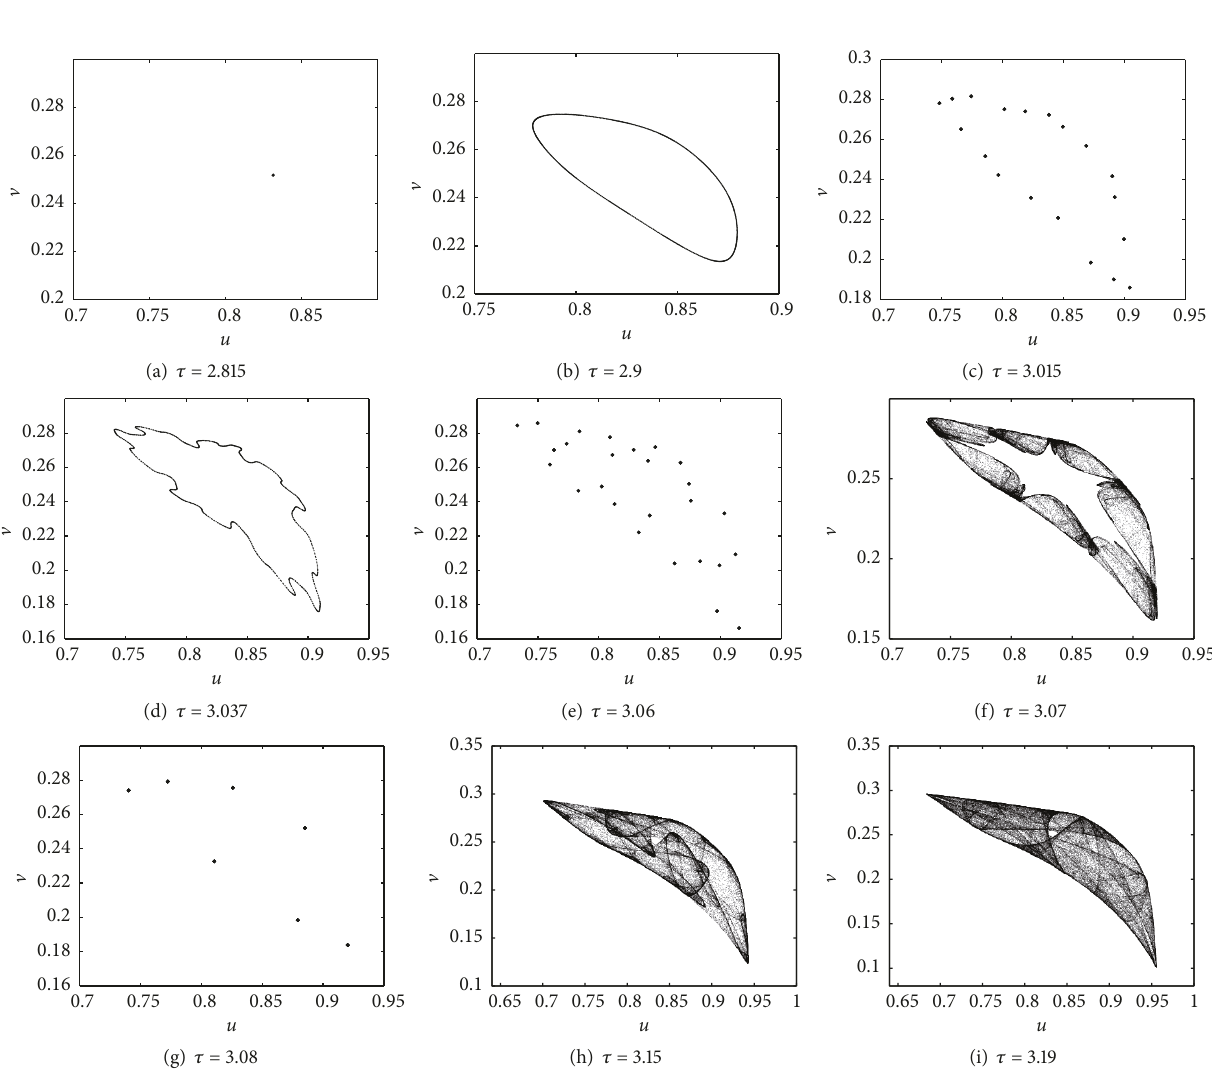
Figure 6: Phase diagrams for different values of parameter 𝜏 corresponding to Figure